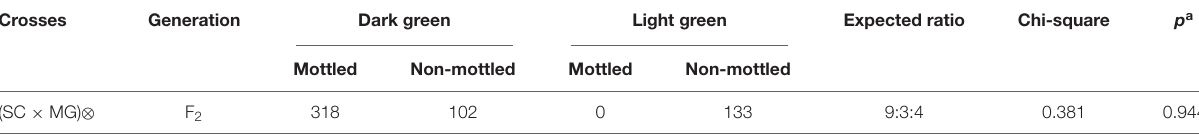
TABLE 2 | Segregation ratio of rind patterns and immature rind color in the F 2 populations. Crosses Generation Dark green Light green